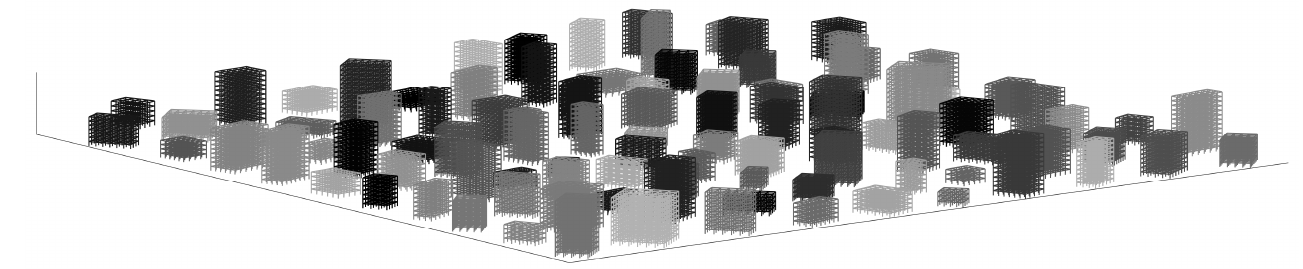
Figure 1. One hundred simulated 3D structural models.